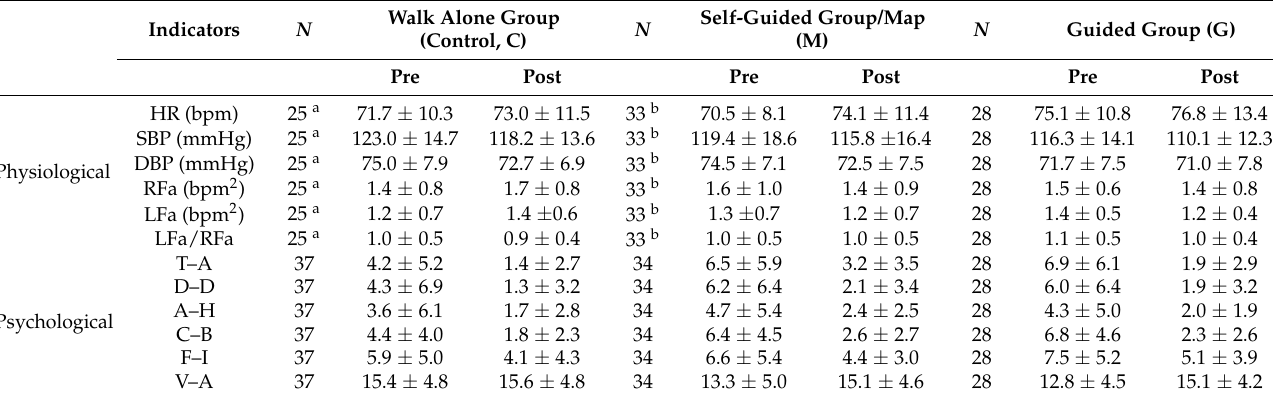
Table 4. Descriptive analysis among three